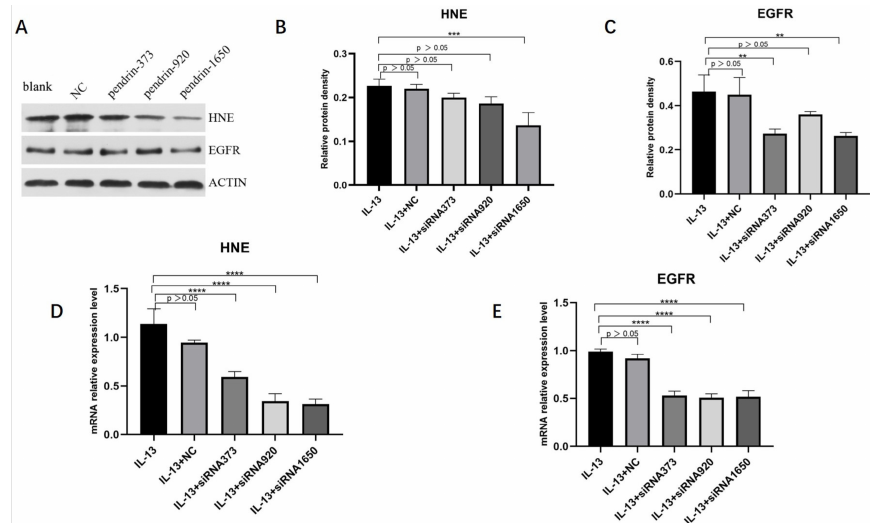
Figure 7. After IL-13 (50 ng/mL) stimulation and transfection with siRNA pendrin (NC, pendrin-373, pendrin-920, pendrin-1650, and FAM NC), WB and qRT-PCR showed that the expression levels of HNE and EGFR were downregulated. ( A ) is the protein expression of HNE, EGFR and ACTIN, ( B , C ) is the density of ( A ) HNE and EGFR. ( D , E ) is the mRNA expression of HNE and EGFR after transfection with siRNA pendrin. ** represents p < 0.01, *** represents p < 0.001, **** represents p <